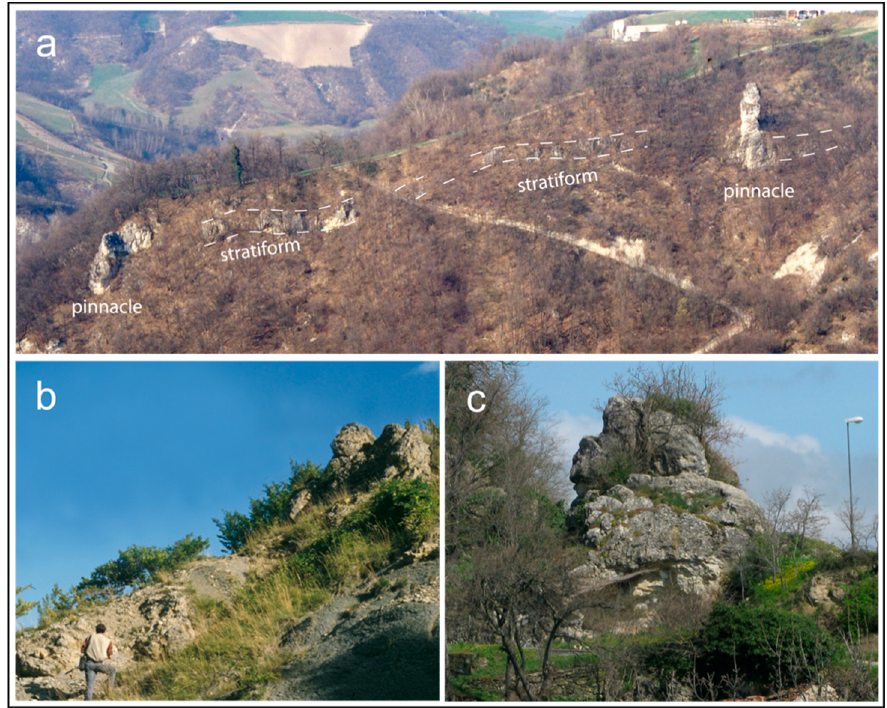
Figure 3. Seep-carbonate outcrops from the three examined geological settings. ( a ) Seep-car- bonates hosted in the wedge-top basin (Termina Fm) in the Montebaranzone area (outcrop 1 in Figure 1), dotted line marks the geometry of the seep-carbonate bodies. ( b ) Castagno d’Andrea seep-carbonates enclosed in pelitic interval of the inner foredeep (Marnoso-arenacea Fm), (outcrop 20 in Figure 1). ( c ) Montepetra seep-carbonates hosted in slope fine-grained sediments (Ghioli di letto Fm), (outcrop 13 in Figure